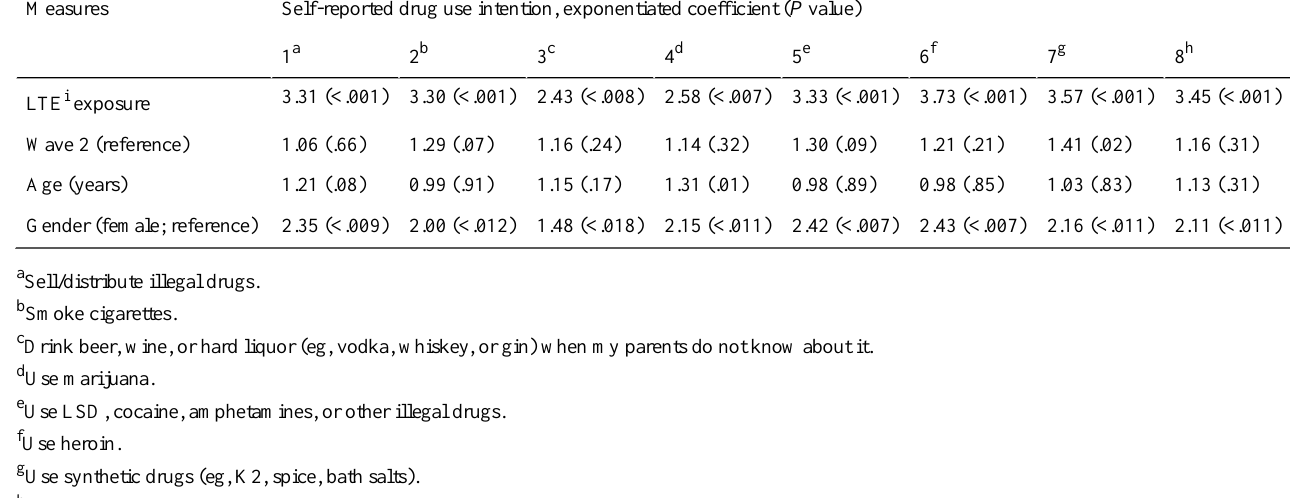
Table 3. Logistic regressions of drug use intentions on Living the Example program exposure and survey waves 2 to 3, exponentiated coefficient. Self-reported drug use intention, exponentiated coefficient ( P